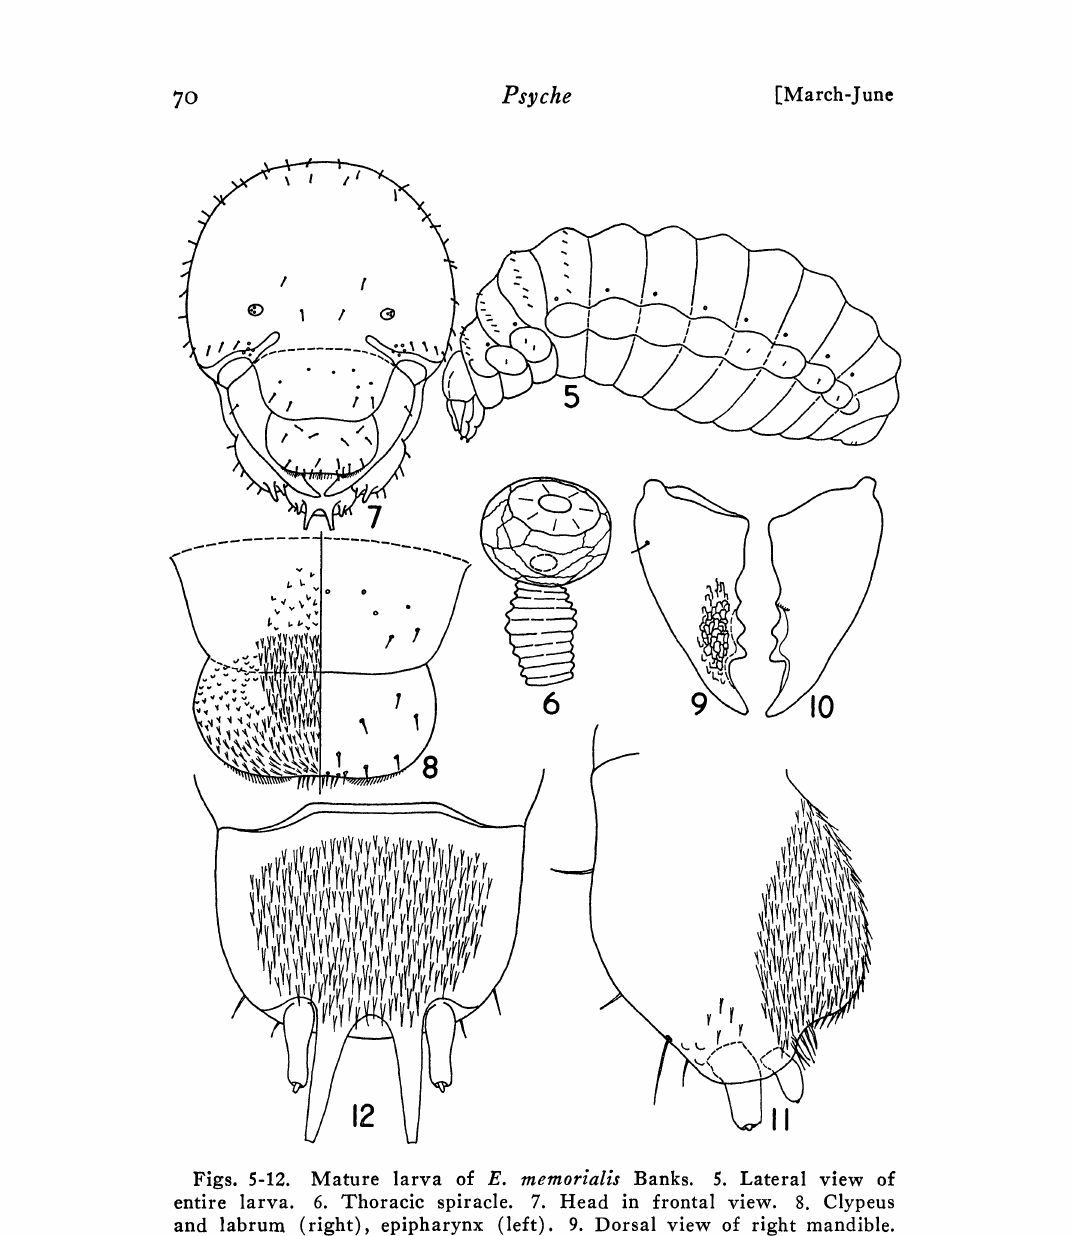
Figs. 5-12. Mature larva of E. memorialis Banks. 5. Lateral view of entire larva. 6. Thoracic spiracle. 7. Head in frontal view. 8. Clypeus and labrum (right), epipharynx (left). 9. Dorsal view of right mandible. 10. Ventral view of right mandible. 11. Dorsal view of right maxilla. 12. Dorsal view of prementum of